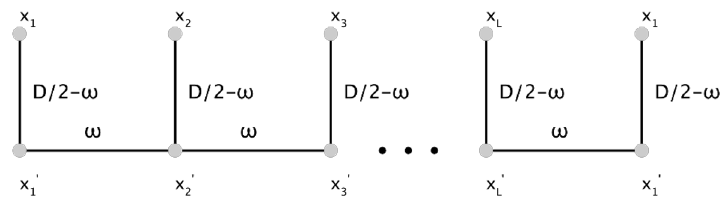
Figure 1 . Graphical representation of H L . The powers of the propagators in coordinate space are explicitly written. The periodical boundary condition is implemented for the double-trace case.